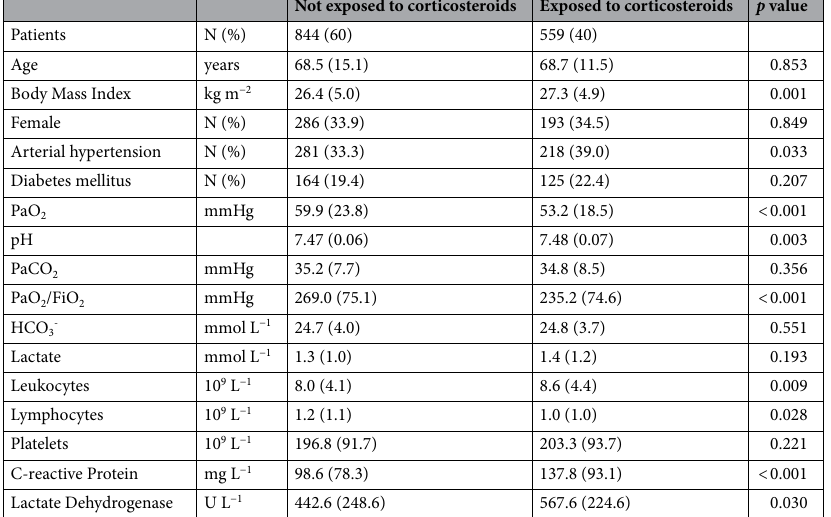
Table 1. Demographics, comorbidities, laboratory data and outcomes of the study subjects. Factor variables are expressed as count (%), continuous variables as mean (standard deviation) or as median (interquartile range). Fisher test was used for factorial variables and t-test and Mann–Whitney test for continuous ones. BMI, body mass index; PaO 2 partial pressure of arterial oxygen; PaCO 2 partial pressure of arterial carbon dioxide; PaO 2 /FiO 2 , partial pressure of arterial oxygen to the fraction of inspired oxygen.